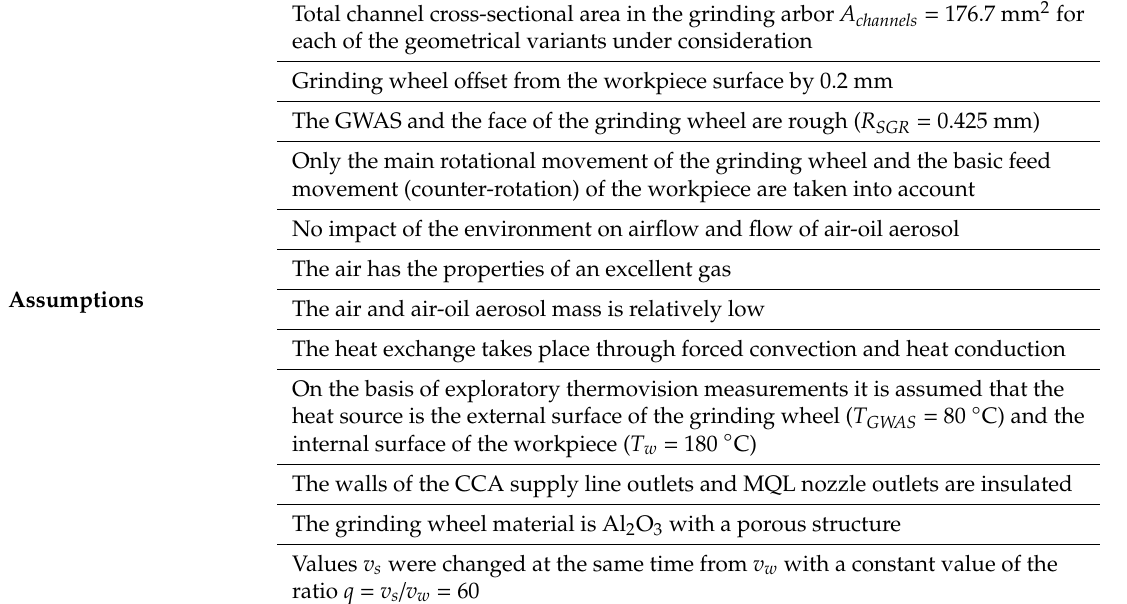
Table 2. Assumptions of